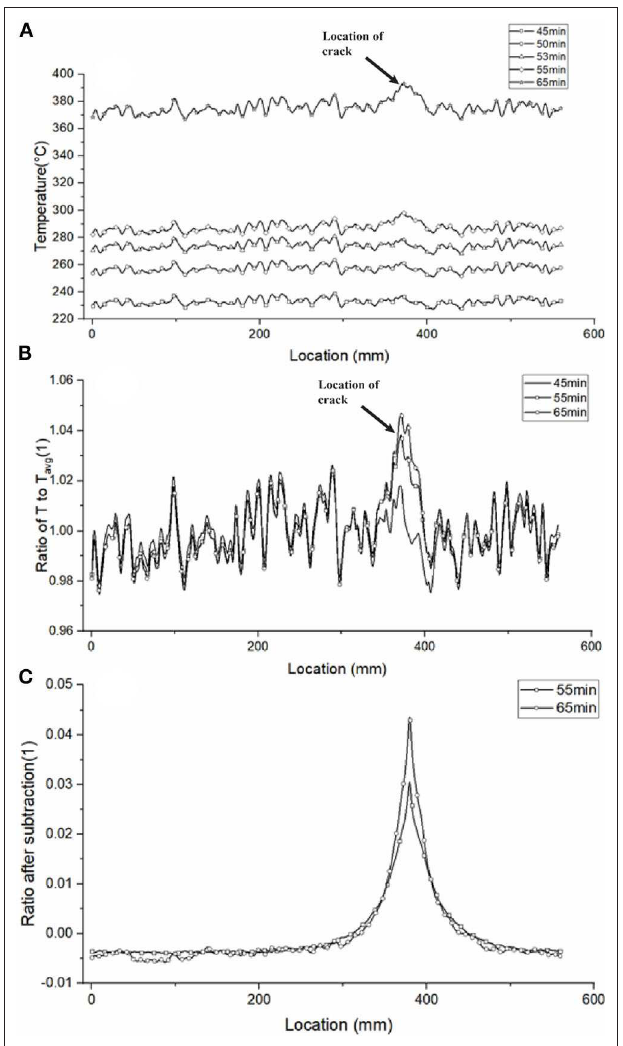
FIGURE 6 | (A) Temperature distribution of beam model II, (B) normalized temperature by T avg , and (C) normalized temperature after subtraction of temporal temperature data.